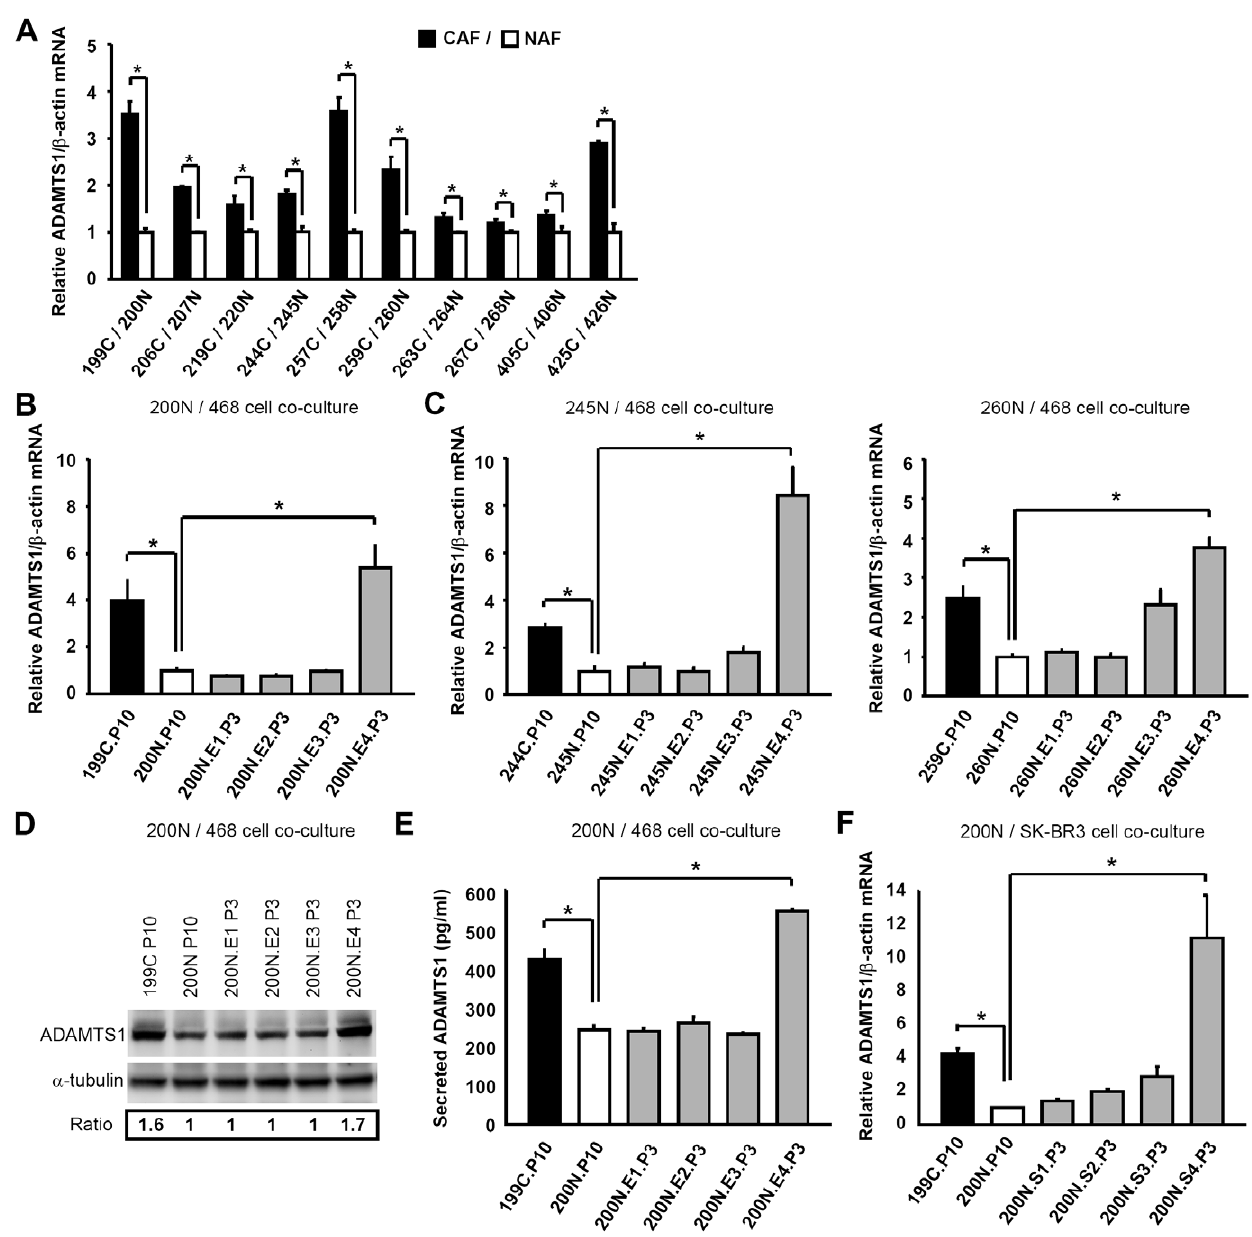
Figure 2. Pre-coculture with breast cancer cells increased ADAMTS1 mRNA levels in NAFs. (A–C) Quantitative real-time RT-PCR analysis revealed that ADAMTS1 mRNA levels were higher in CAFs than in the corresponding NAFs in ten breast cancer patients (A), and that ADAMTS1 mRNA levels in CAF 199C.P10 and NAF 200N.E4.P3 were higher than in NAF 200N.P10 and 200N.E1-E3.P3 (B). Similar results are shown using the pairs of CAF 244C/NAF 245N and CAF 259C/NAF 260N (C). (D) The ADAMTS1 protein level in NAF 200N.E4.P3, but not NAF 200N.E1-E3.P3, was enhanced to the similar level in CAF 199C.P10, compared to NAF 200N.P10. (E) ELISA indicated that the ADAMTS1 protein level in cultured medium derived from NAF 200N.E4.P3 was higher than NAF 200N.E1-E3.P3 and NAF 200N.P10. (F) ADAMTS1 mRNA level in SK-BR-3 cell-precocultured NAF 200N.S4.P3 was also higher than in NAF 200N.P10 and 200N.S1-S3.P3. Data are shown as mean 6 SD from triplicate experiments. Statistical significance was evaluated by Student’s t-test. * P ,